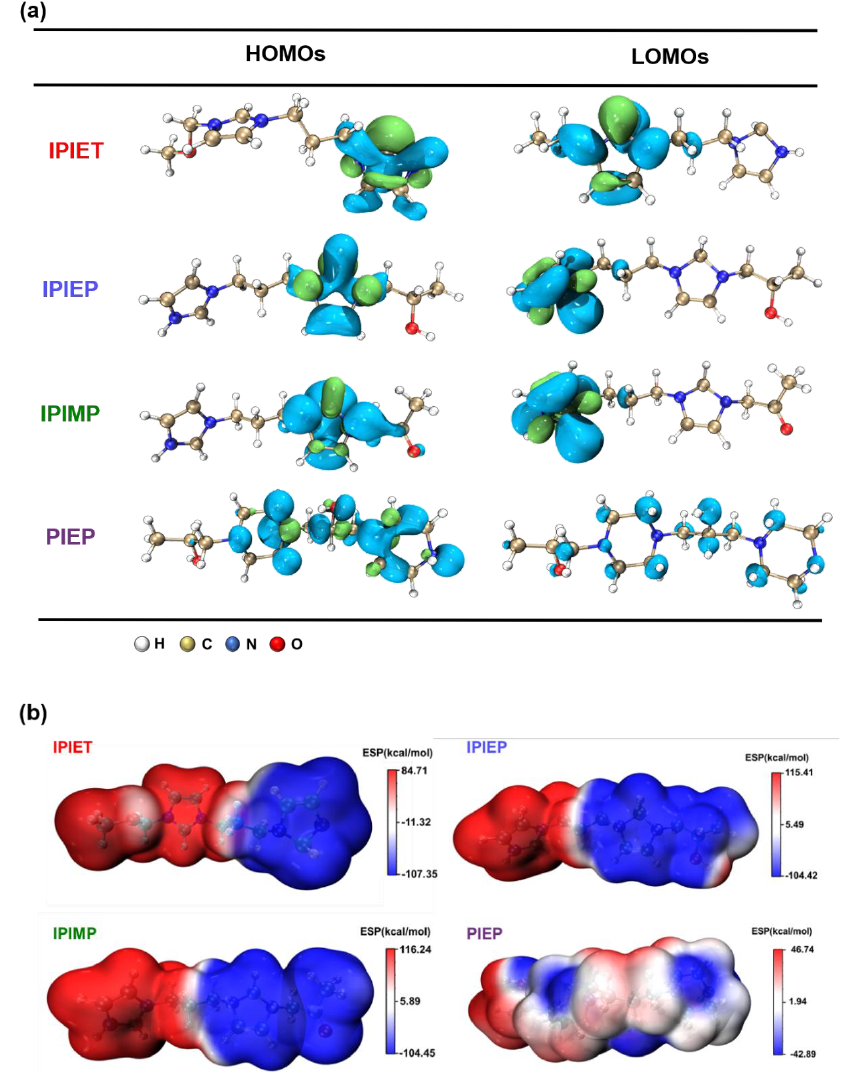
Figure 6. ( a ) Distributions and orbital energy values of the HOMO and LUMO for the four oligomers. ( b ) The ESP maps of the four oligomers. Table 1. Energy values of molecular orbital and bandgap energy (ΔEg) of oligomers.